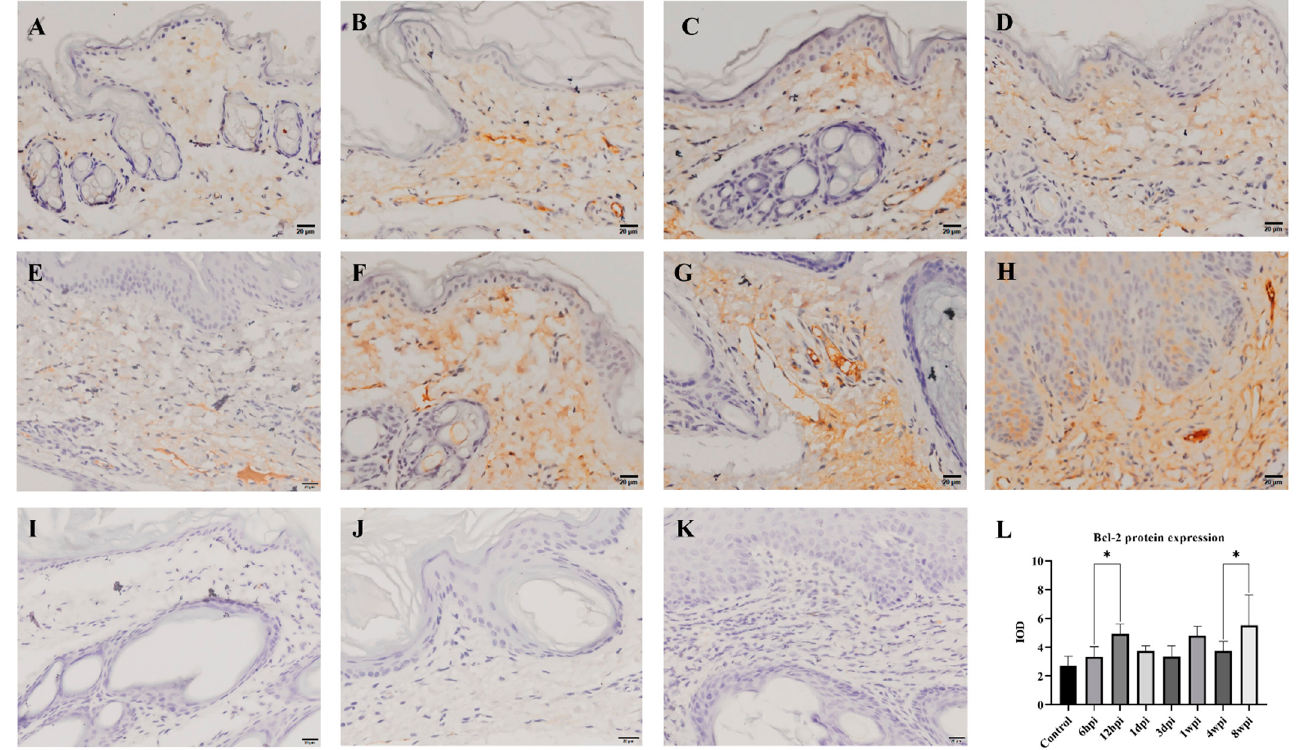
Figure 8. Bcl-2 protein expression was detected by immunohistochemical staining. ( A ) Control, ( B ) 6 hpi, ( C ) 12 hpi, ( D ) 1 dpi, ( E ) 3 dpi, ( F ) 1 wpi, ( G ) 4 wpi, ( H ) 8 wpi, ( I – K ) negative control, ( L ) integral optical density (IOD) of Bcl-2 protein expression. Brownish-yellow staining indicates Bcl-2 antigenicity (cytoplasmic staining). The IOD values of Bcl-2 protein expression are represented as the mean ± standard deviation (M ± SD). A one-way ANOVA was used to analyze the variances between groups. The horizontal line indicates a significant adjacent pairwise group difference (* p < 0.05 and ** p < 0.01). Scale bar = 20 μ m.